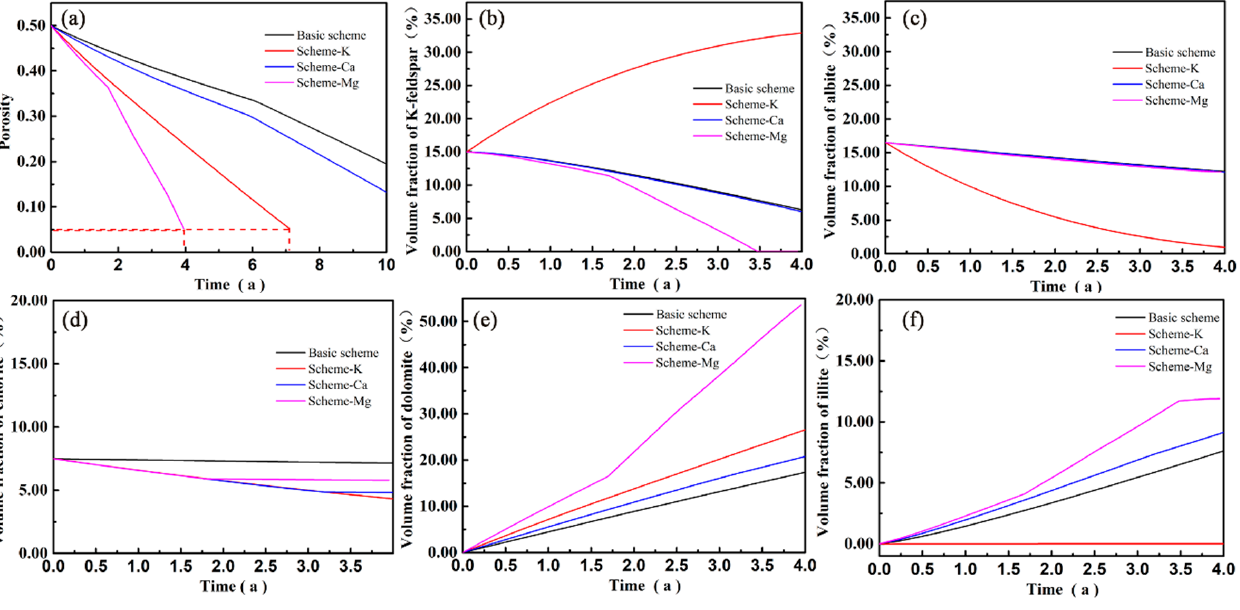
Figure 11. Simulation results under different hydrochemical compositions. ( a )—Porosity; ( b )—K- Feldspar; ( c )—Albite; ( d )—Chlorite; ( e )—Dolomite; ( f